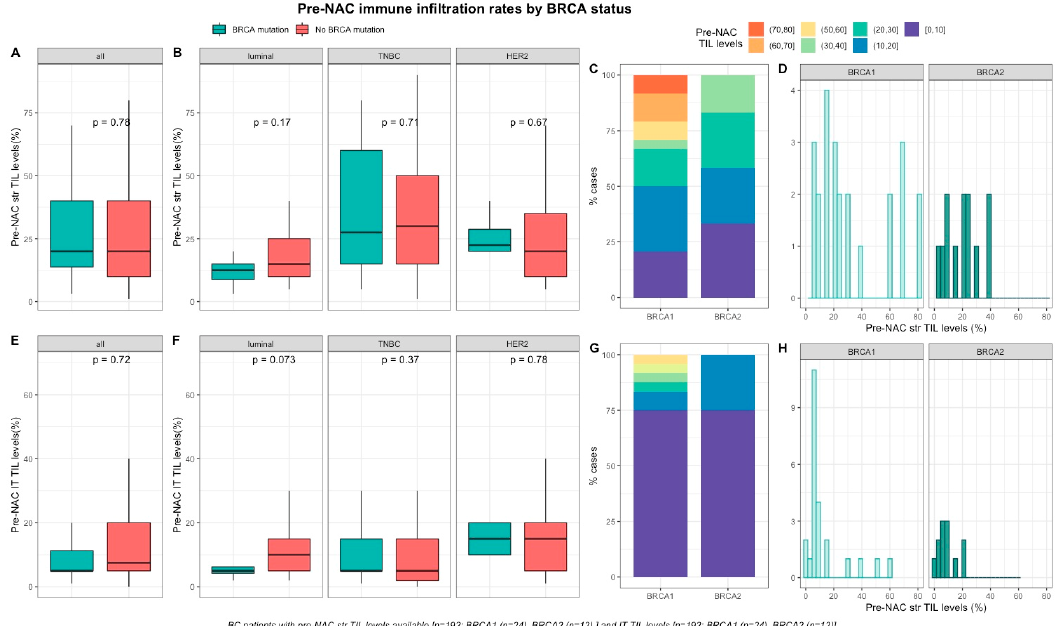
Figure 1. Associations between pre-NAC TILs and BRCA status in whole population, and by breast cancer subtype. Bottom and top bars of the boxplots represent the first and third quartiles, respectively, the medium bar is the median, and whiskers extend to 1.5 times the interquartile range. ( A ) stromal lymphocytes among the whole population (All ( n = 192), BRCA mutation ( n = 36), BRCA wild-type ( n = 156)). ( B ) stromal lymphocytes in each BC subtype (Luminal ( n = 52), BRCA mutation ( n = 8), BRCA wild-type ( n = 44); TNBC ( n = 97), BRCA mutation ( n = 24), BRCA wild-type ( n = 73); HER2 ( n = 43), BRCA mutation ( n = 4), BRCA wild-type ( n = 39)). ( C ) percentage of tumor according to pre-NAC stromal lymphocytes levels binned by 10% increment in patients with BRCA -deficient ( BRCA 1 ( n = 24), BRCA 2 ( n = 12)). ( D ) distribution of pre-NAC stromal lymphocytes by gene mutations (histogram plot) in patients with BRCA -deficient ( BRCA 1 ( n = 24), BRCA 2 ( n = 12)). ( E ) intratumoral lymphocytes among the whole population (All ( n = 192), BRCA mutation ( n = 36), BRCA wild-type ( n = 156)). ( F ) intratumoral lymphocytes in each BC subtype (Luminal ( n = 52), BRCA mutation ( n = 8), BRCA wild-type ( n = 44); TNBC ( n = 97), BRCA mutation ( n = 24), BRCA wild-type ( n = 73); HER2 ( n = 43), BRCA mutation ( n = 4), BRCA wild-type ( n = 39)). ( G ) Percentage of tumor according to pre-NAC intratumoral lymphocytes levels binned by 10% increment in patients with BRCA -deficient ( BRCA 1 ( n = 24), BRCA 2 ( n = 12)). ( H ) distribution of pre-NAC intratumoral lymphocytes by gene mutations (histogram plot) in patients with BRCA -deficient ( BRCA 1 ( n = 24), BRCA 2 ( n = 12)).